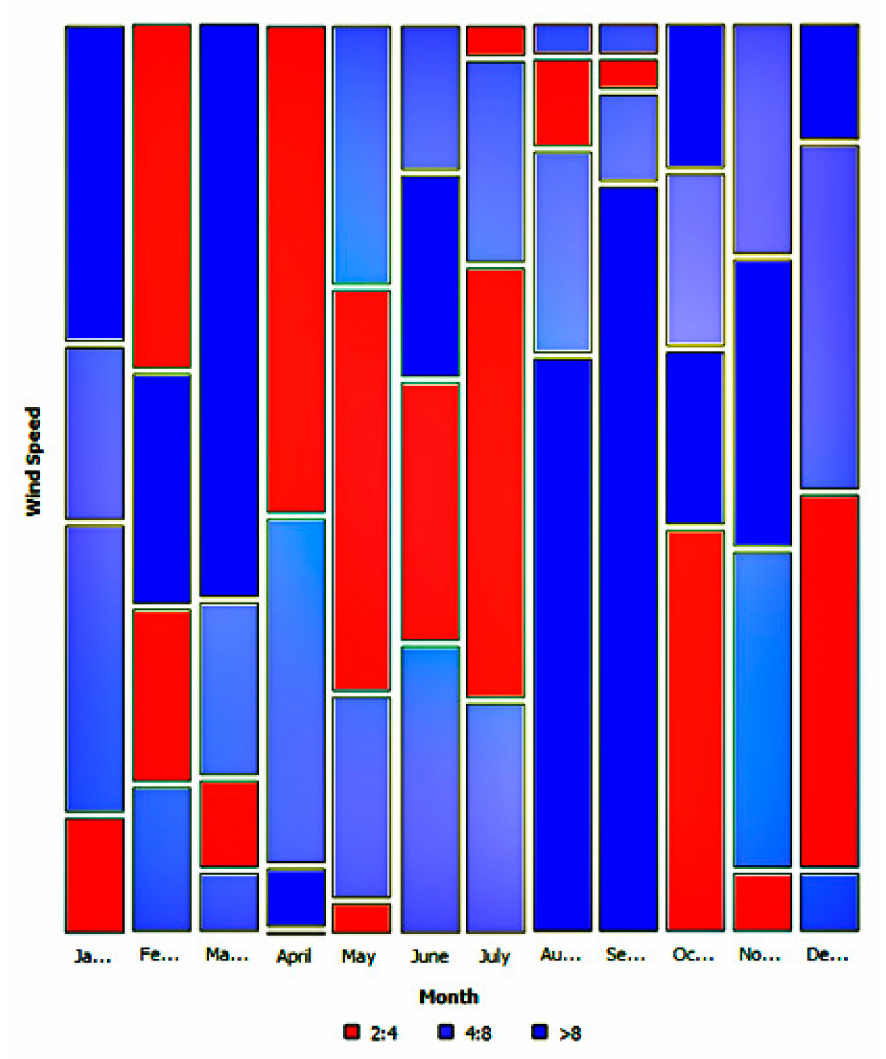
Figure 11. Wind speed clustering in the Mexican states of the Gulf of